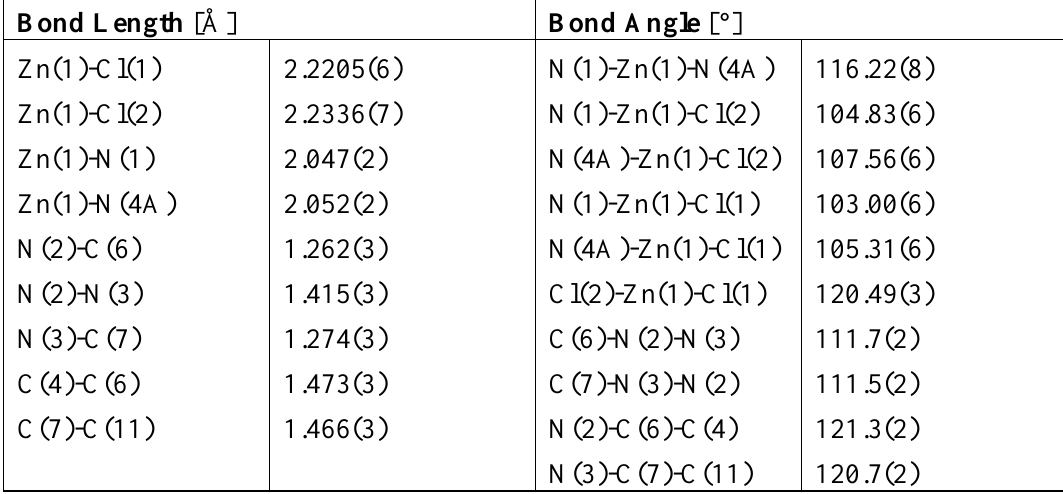
Table 2. Selected bond lengths and angles around the Zn(II) for compound